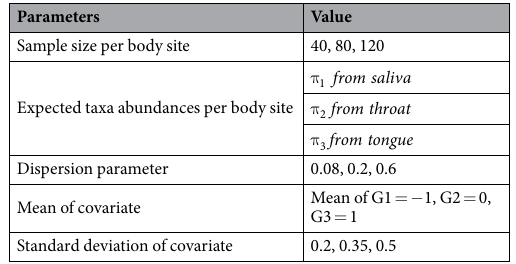
Table 3. Summary of parameters in simulation studies. Averaged misclassification error rate of the validation data of 100 iterations. The number in each cell is expressed as a percentage.